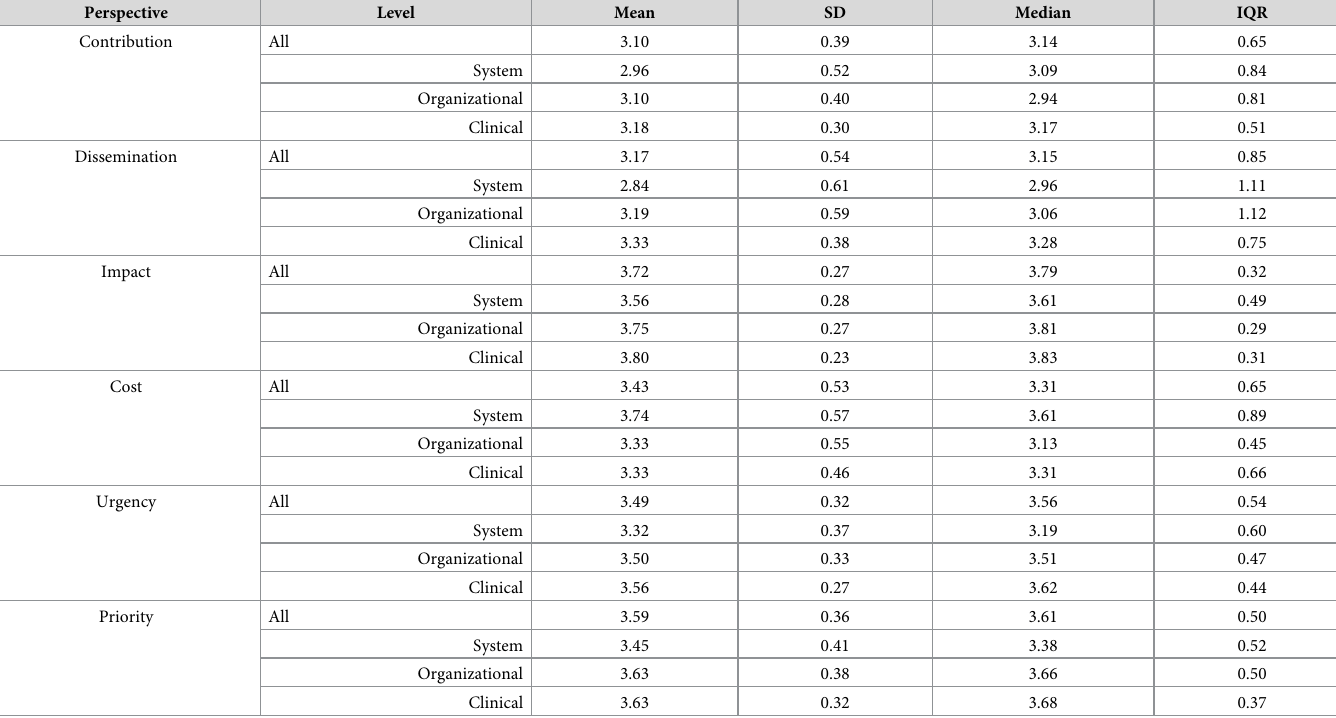
Table 5. Scores by the level of interventions in each perspective.